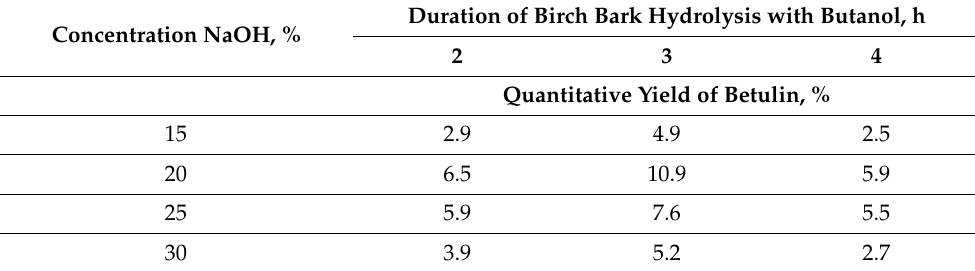
Table 1. Data on the yield of betulin extracted with butanol from birch bark of the Kirgyz birch, hydrolyzed in the presence of sodium